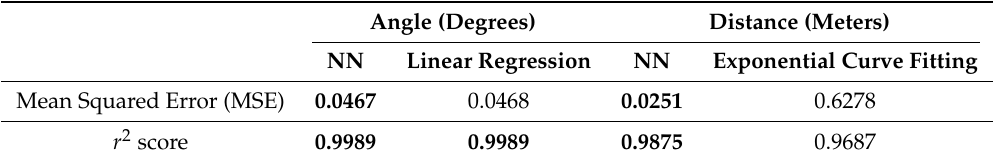
Table 4. Mapping analysis. The best results are shown in bold